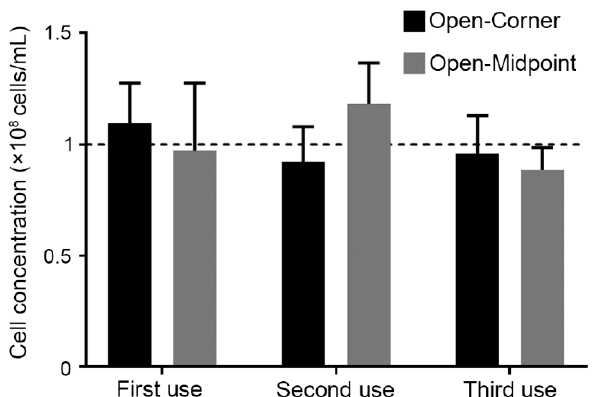
Figure 4. Repeatability of SSCC devices with open-corner and open-midpoint grid configurations for counting of zebrafish sperm (1 × 10 8 cells/mL) ( n = 5; mean ± SEM) with two-way ANOVA multiple comparisons (Dunnet), compared to first use. The dashed line indicates solution concentrations.